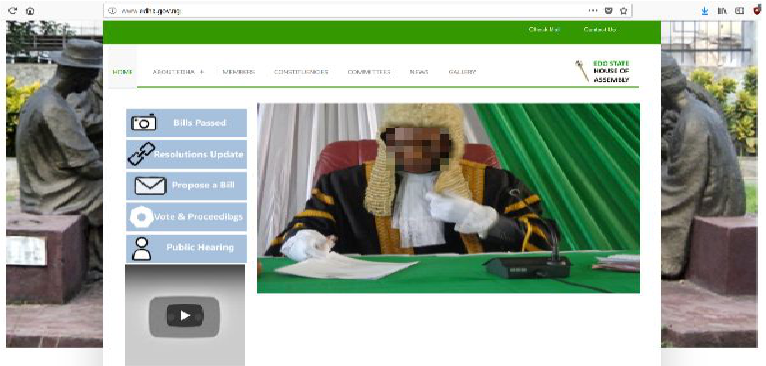
Figure 2: Edo State House of Assembly Official Website (www.edha.gov.ng)